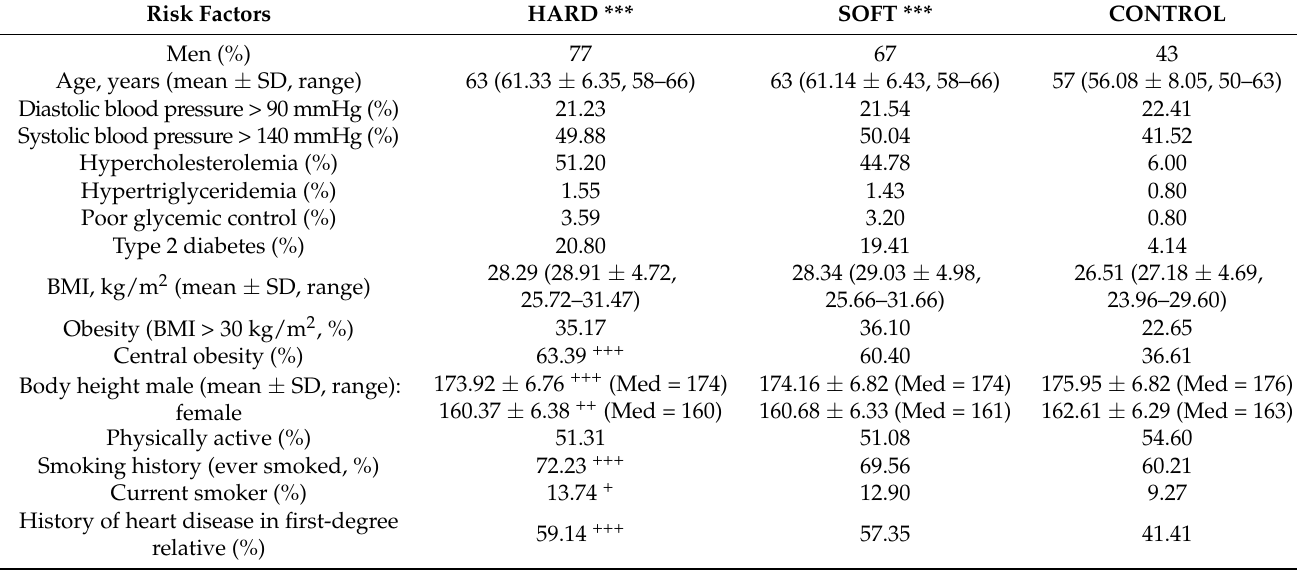
Table 1. Individual characteristics of HARD and SOFT CAD cases vs. controls. *** Represents statistically significant (of p < 0.001) difference between HARD and SOFT CAD cases vs. controls, whereas +++, ++ and + represent statistically significant (of p < 0.001, p < 0.01 and p < 0.05, respectively) difference between HARD vs. SOFT CAD